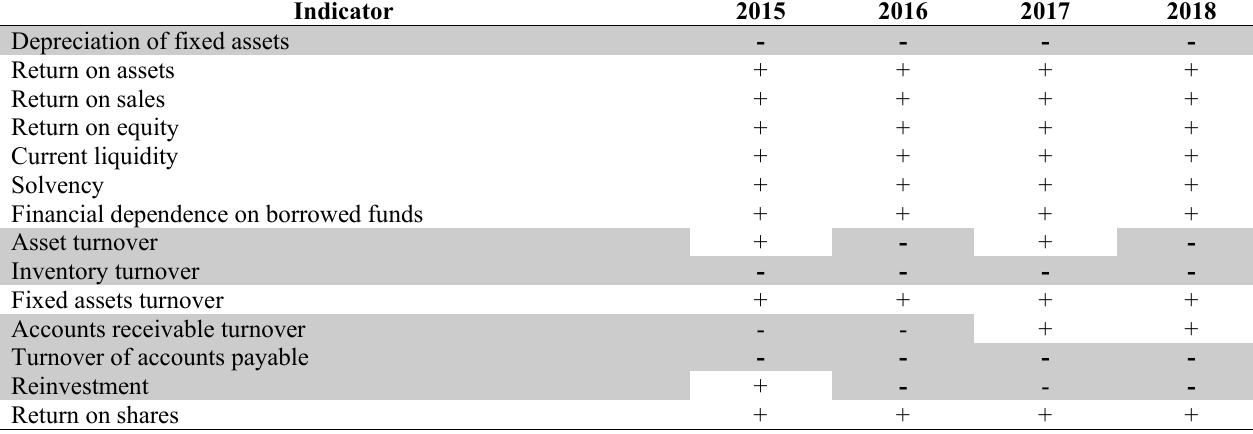
The scope of the restraining and stimulating financial risks of PJSC